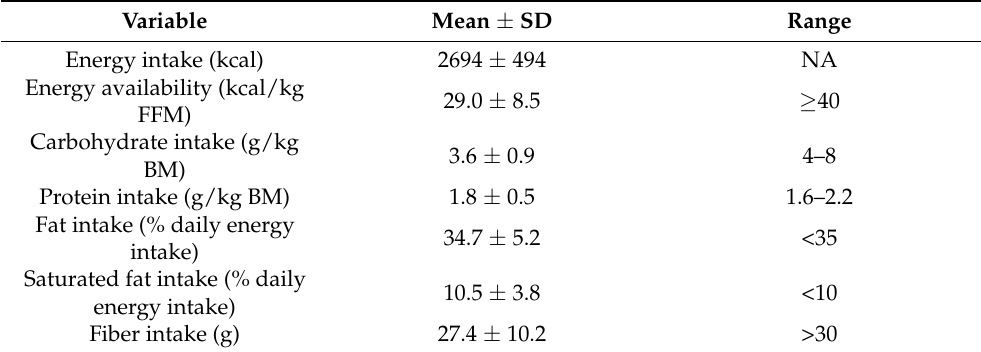
Table 2. Nutritional intake of subjects.